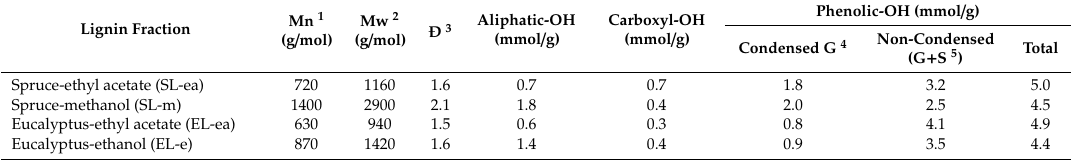
Table 2. Molecular weight characteristics and content of functional groups in lignin solvent